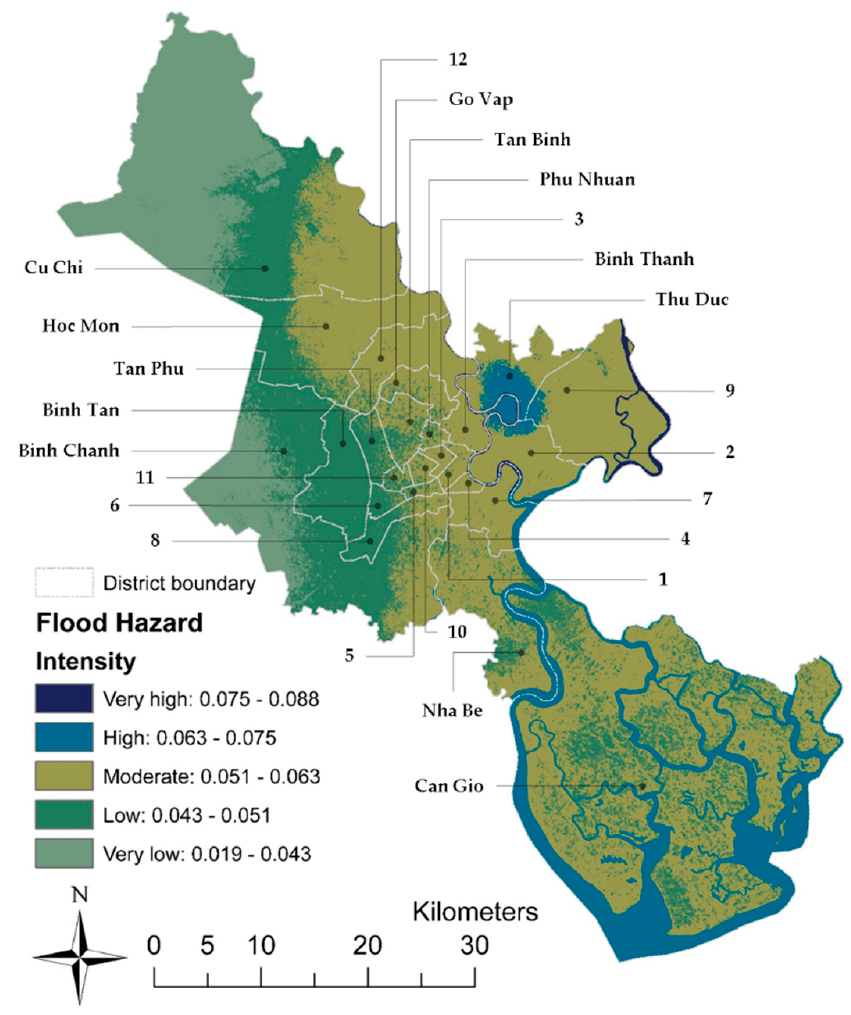
Figure 3. The spatial distribution of flood hazard in HCMC.